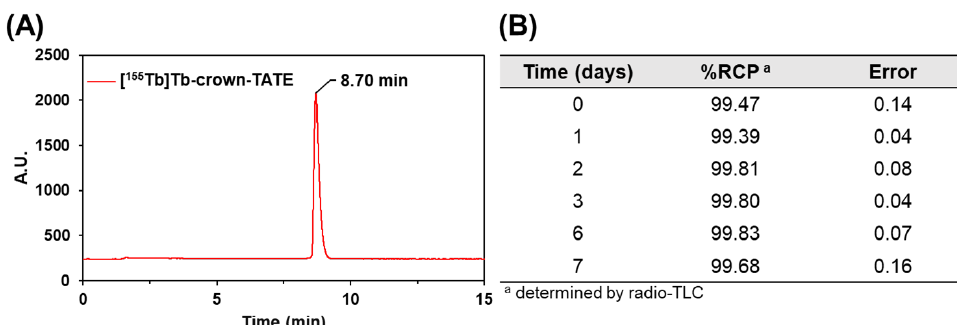
Figure 2. ( A ) Radio - HPLC trace of [ 155 Tb]Tb - crown - TATE (19.4 MBq/nmol), prepared in NH 4 OAc buffer (0.5 M, pH 6.0) at ambient temperature after 10 min; >99% RCP. ( B ) Human serum stability challenge of [ 161 Tb]Tb - crown - TATE (11.4 MBq/nmol), incubated at 37 °C, monitored over 7 days ( n = 3); RCP determined by radio - TLC using SG - paper plates and EDTA (50 mM, pH 5.5) as eluent.